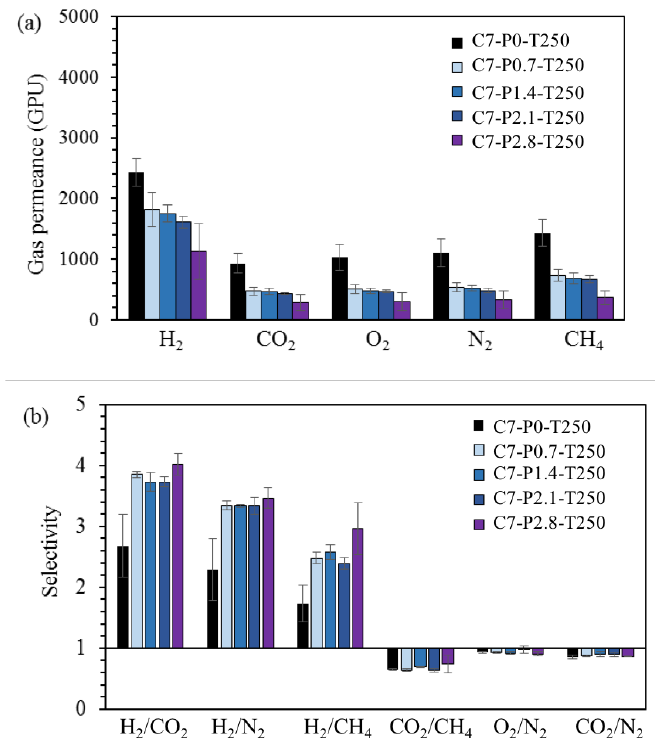
Figure 10. Gas separation performances obtained from rubber-derived TR membranes as a function PPO additive content. ( a : single gas permeance; b : selectivity of di ff erent gas of PPO additive content. ( a : single gas permeance; b : selectivity of different gas pairs).